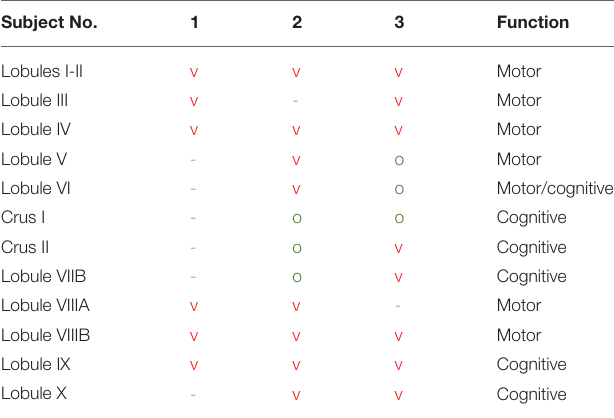
TABLE 1C | Cerebellar atrophy SCA3 subjects.